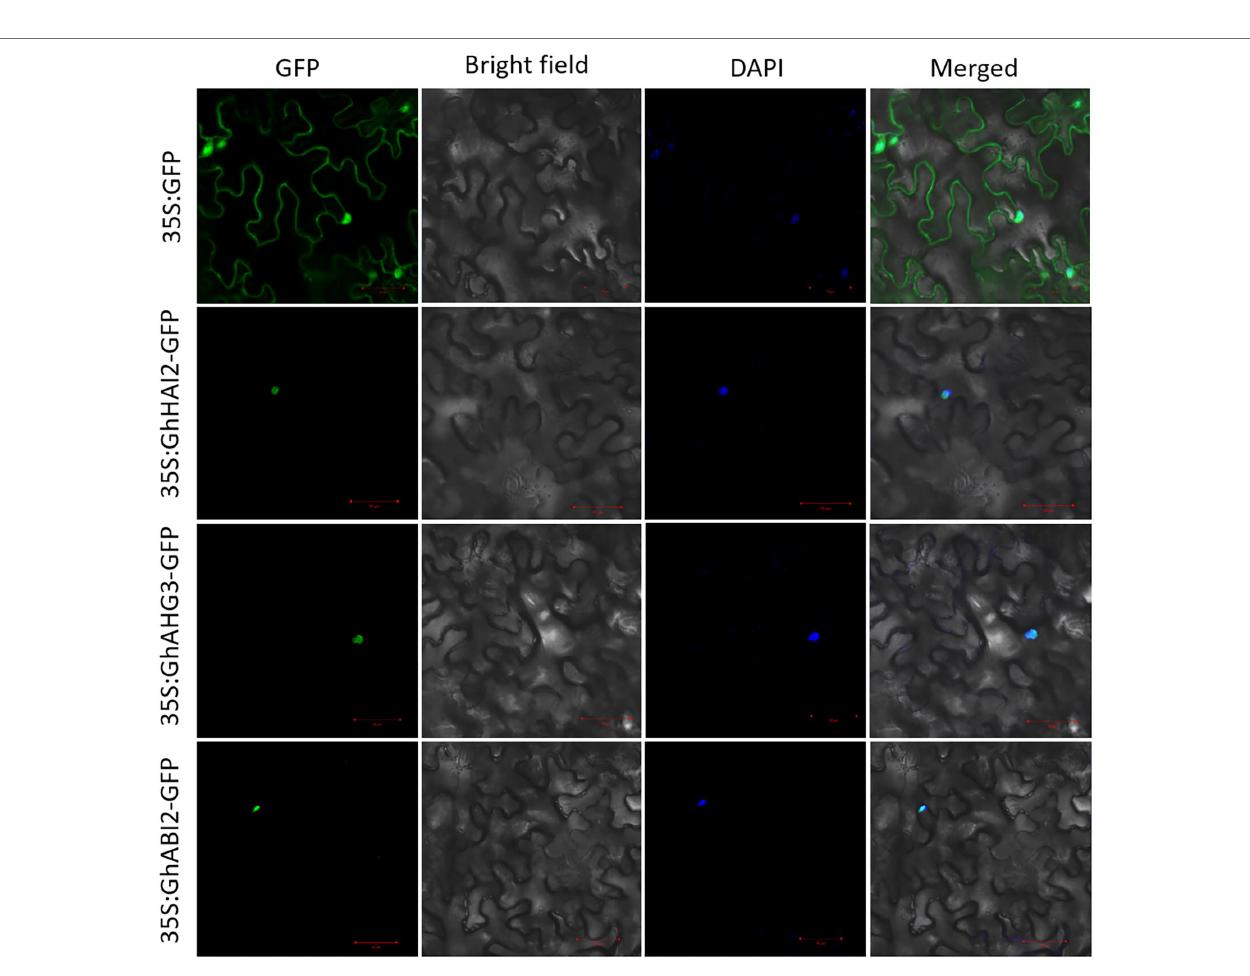
FIGURE 2 | Subcellular localization of GhHAI2, GhAHG3, and GhABI2 based on the transient expression of green fluorescent (GFP) fusion protein in the epidermal cells of N. benthamiana . The 35S:GhHAI2 - GFP, 35S:GhAHG3-GFP, and 35S:GhABI2-GFP constructs were expressed in the leaves of N. benthamiana using agroinfiltration method. The GFP signal was observed using a confocal laser-scanning microscope. The DAPI staining was used as nucleus